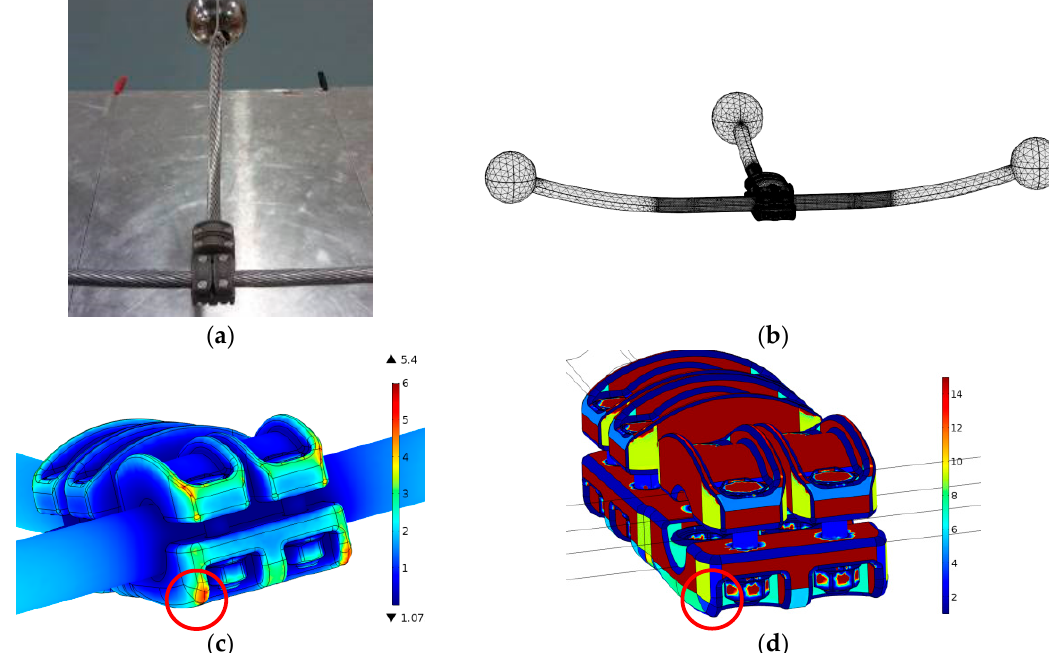
Figure 8. ( a ) Experimental layout with the center of the conductor placed at a height of 225 mm above